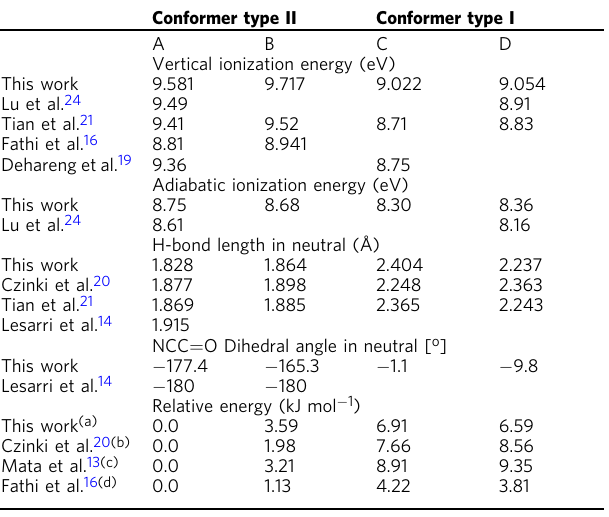
Table 1 Summary of calculated energetics/ionization energies/geometry for the four main conformers of